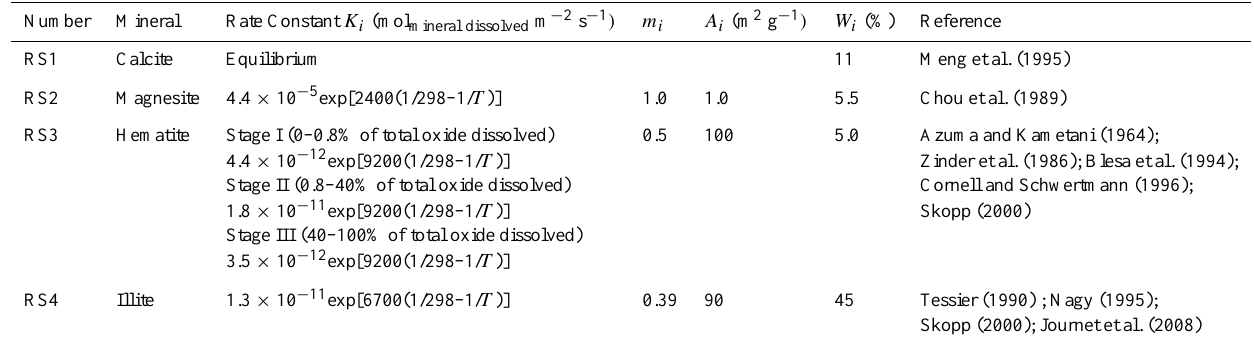
Table 1. Constants Used to Calculate Mineral Dissolution/Precipitation